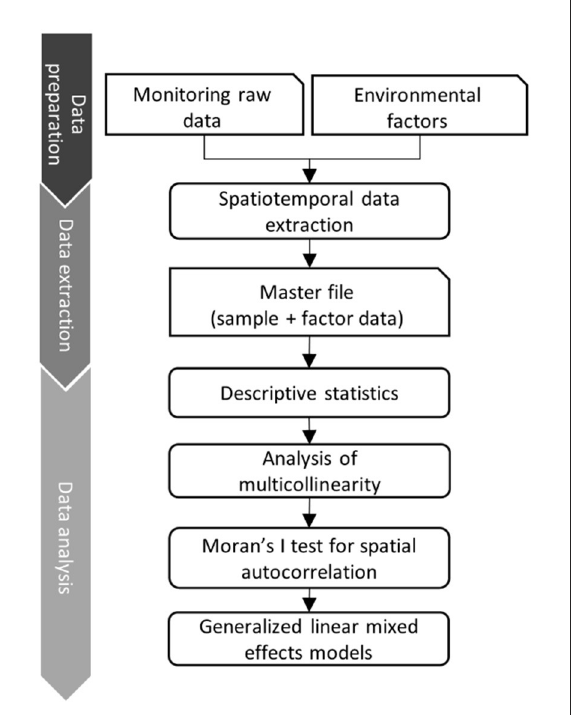
FIGURE2 Data analysis pipeline that combines monitoring raw data with data of explicit environmental factors (right vertical axis). On the left the 3 main steps of the data pipeline are